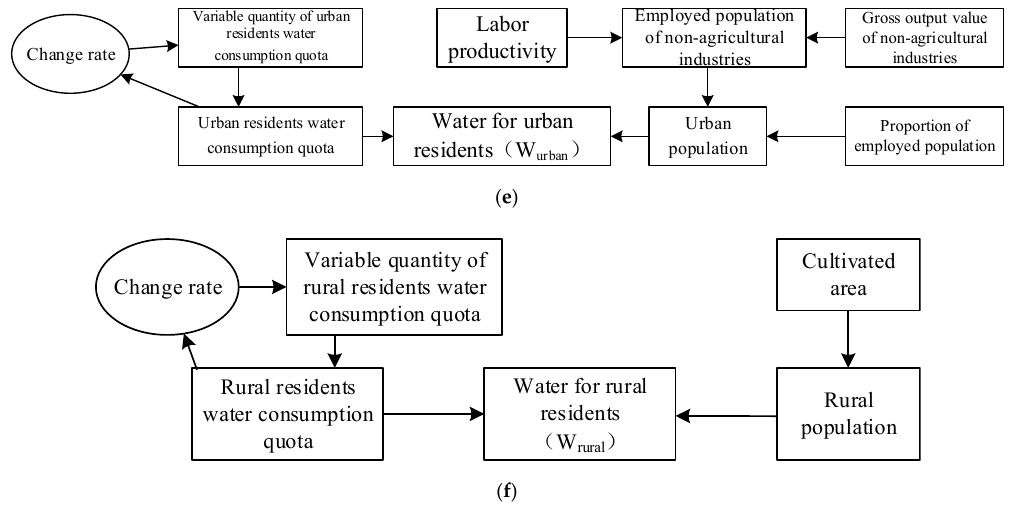
Figure 3. The causal relationships among the main factors in the Xiong’an system dynamics (SD) model: ( a ) total water supply, ( b ) total water consumption, ( c ) agricultural water use, ( d ) nonagricultural industries’ water use, ( e ) water for urban residents, and ( f ) water for rural residents.